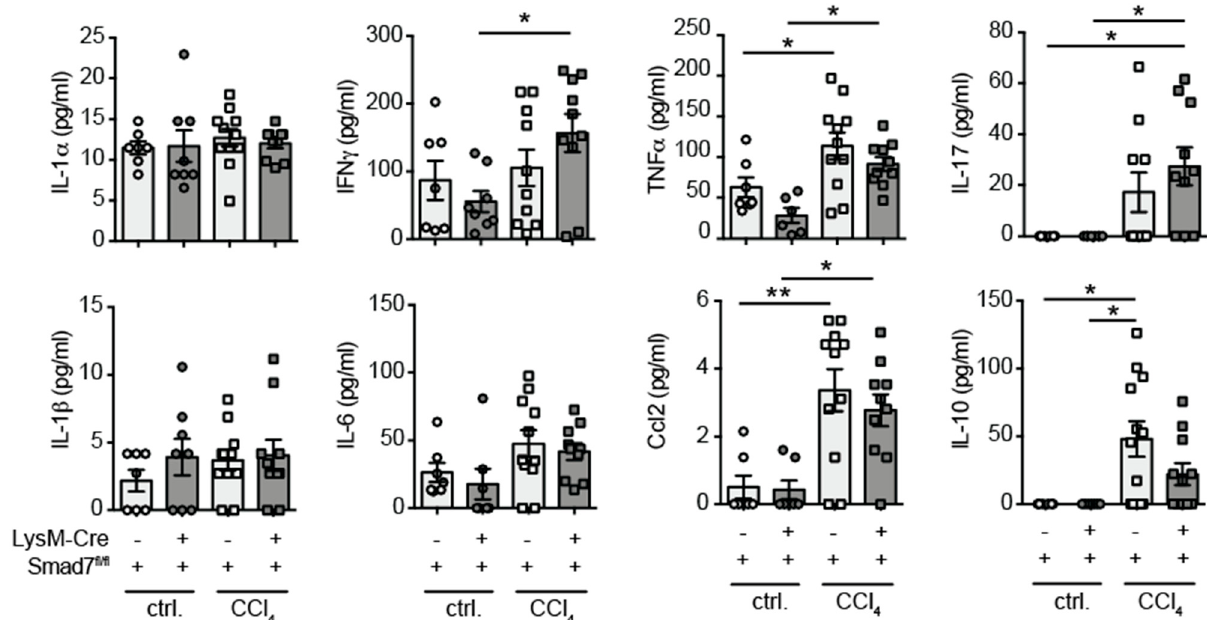
Figure 3. Proinflammatory cytokine production by hepatic NPCs was not influenced by the absence of Smad7. LysM-Cre pos Smad7 Δ / Δ and Smad7 fl/fl littermates were injected intraperitoneally with CCl 4 in corn oil or corn oil alone (ctrl.) twice a week for 6 wks. Mice were sacrificed 24 h after the last CCl 4 –oil application. NPCs isolated from the liver were stimulated in vitro with PMA, ionomycin and LPS. Supernatants were collected 24 h later, and cytokine content was measured using the LEGENDplex 13× Mouse Inflammation Panel. Data shown are cumulative data of 5 independent experiments with 3–5 animals per group. Data are displayed as the mean ± SEM. ANOVA analysis of the data did not reveal significant differences between LysM-Cre pos Smad7 Δ / Δ and Smad7 fl/fl groups after CCl 4 treatment. * p ≤ 0.05, ** p ≤ 0.01.